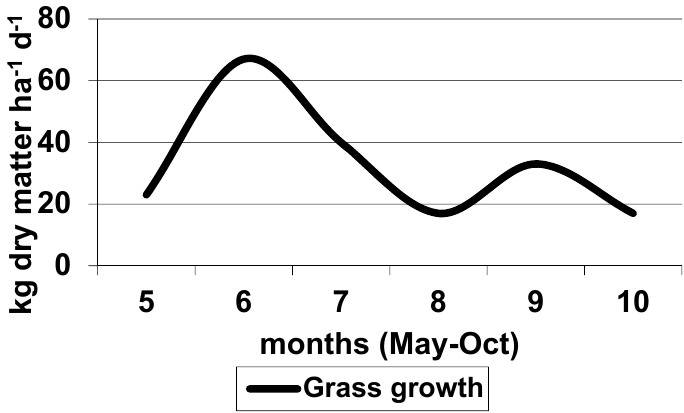
Figure 1. The average growth of pasture grass in Central Italy during the grazing period [modified from 94].